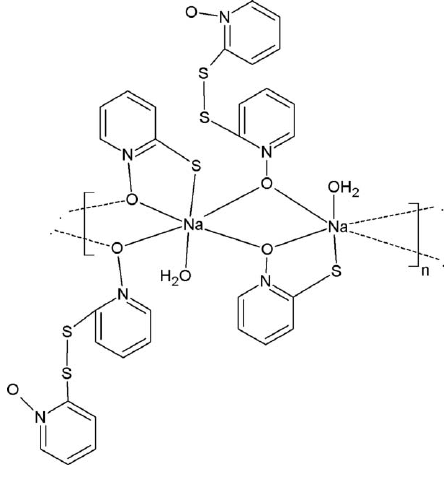
Data collection Bruker SMART APEXII CCD diffractometer Absorption correction: multi-scan ( SADABS ; Sheldrick, 2008 a )